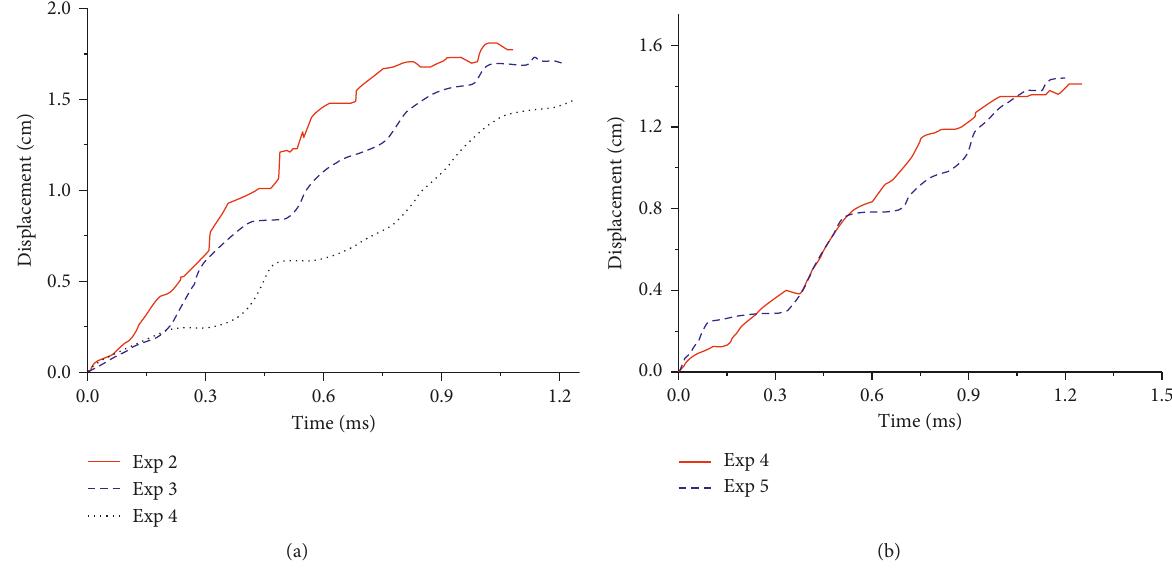
Figure 23: Bottom points of test displacement curves. (a) Tests 2, 3, and 4. (b) Tests 4 and